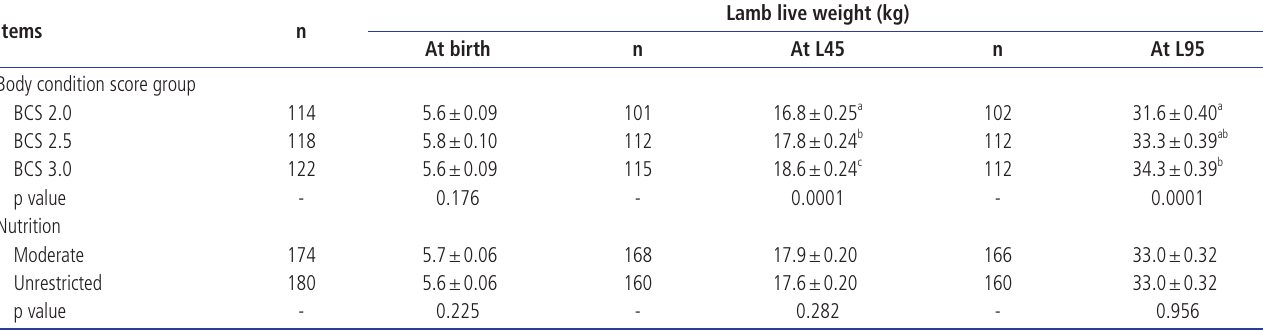
Table 4. Effect of ewe body condition score group (2.0 vs 2.5 vs 3.0) and nutritional treatment in very late pregnancy and lactation (Moderate vs Unrestricted) on lamb live weight (kg; mean±SEM) at birth, L45 and